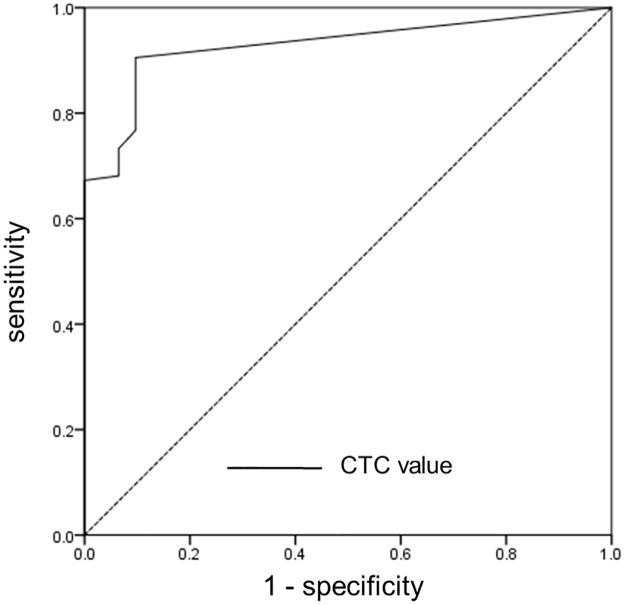
Receiver operating characteristic (ROC) curve.The value of circulating tumor cells (CTCs) showed an area under the ROC curve of 0.928 (95% confidence interval: 0.885–0.971, P < 0.001). To identify the optimal CTC threshold value for differentiating patients with gastric cancer from healthy controls, the sensitivity and specificity were optimized using a threshold count of 2 CTCs per 7.5 mL of blood.